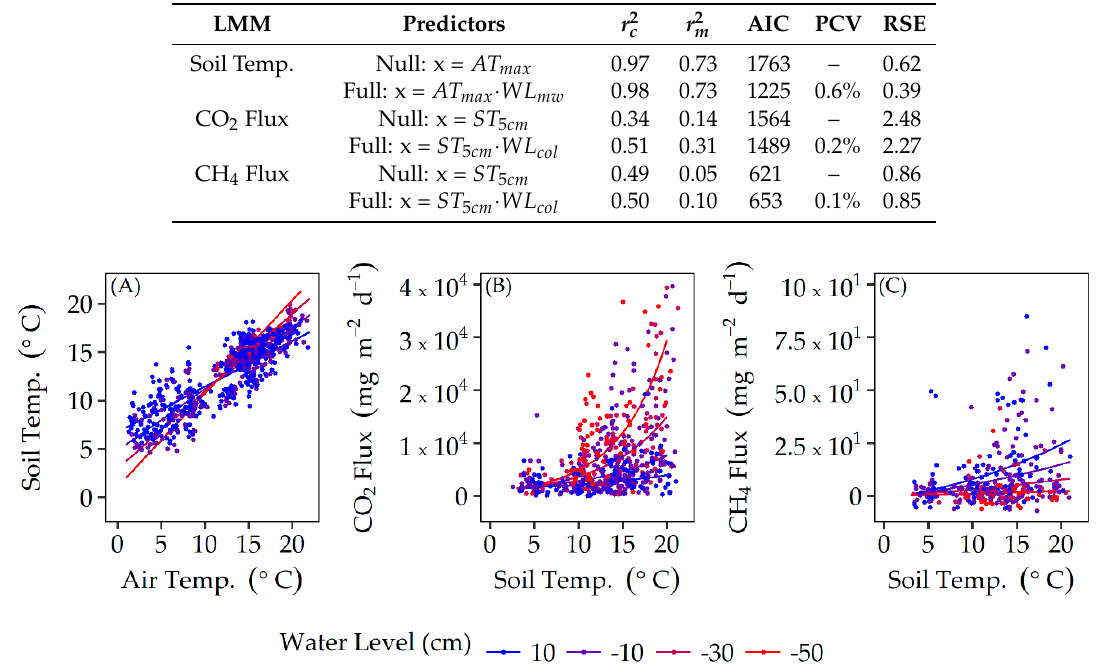
Figure 2. ( A ) Responses of daily maximum soil temperatures to daily maximum air temperatures and water levels; ( B ) Responses of soil CO 2 fluxes to soil temperatures and water levels; ( C ) Responses of soil CH 4 fluxes to soil temperatures and water levels. The lines in each panel represent the predicted [57] responses for four water level positions relative to the wetland soil surface. Observations (points) were color coordinated using equidistant binning for the four water level positions, and are used for visual interpretation only.